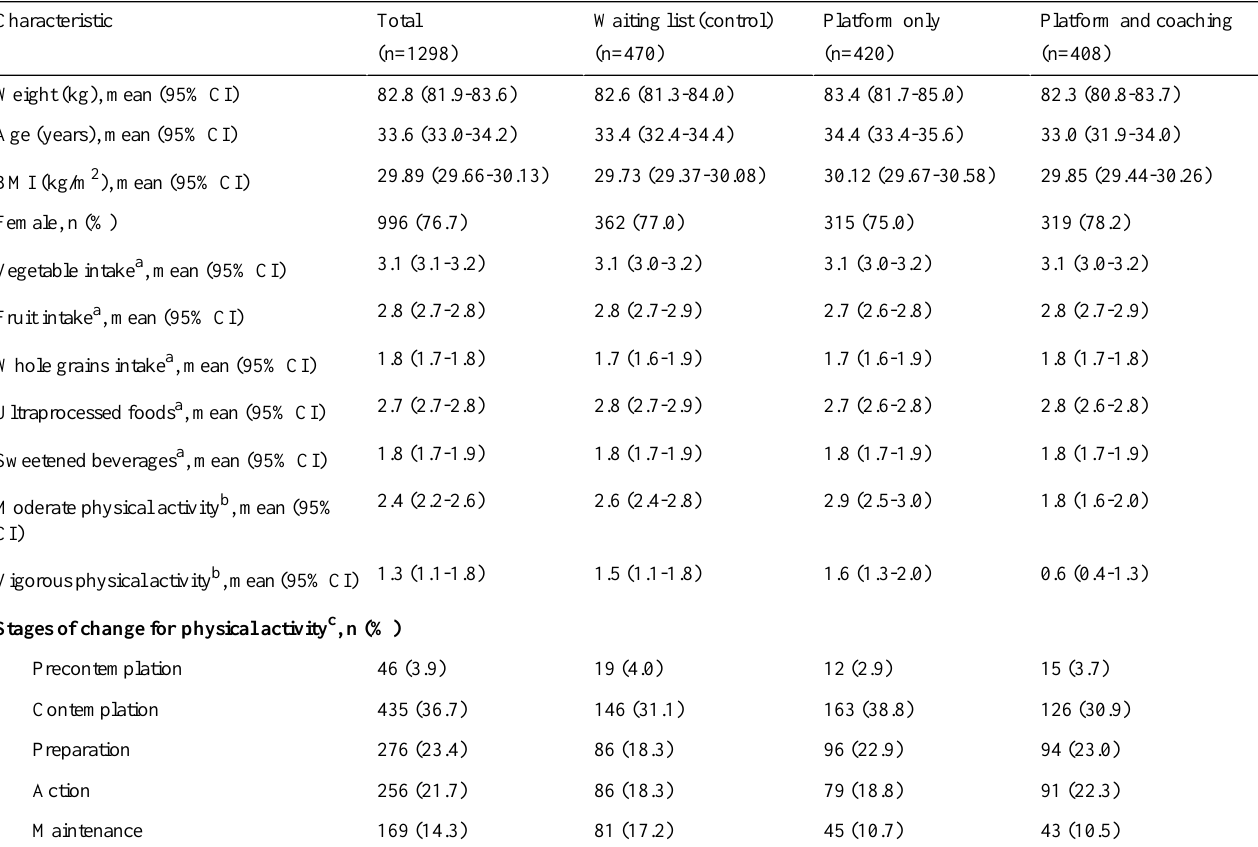
Table 1. Participants’characteristics at